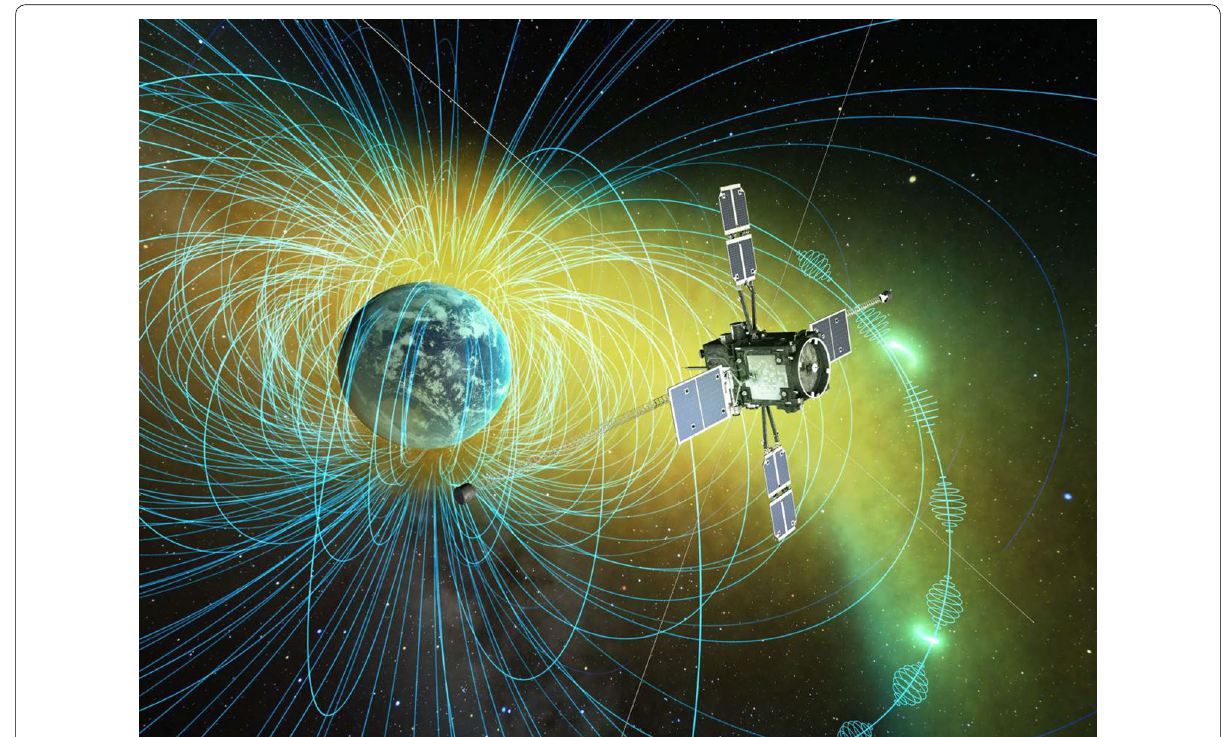
Fig. 1 Image showing the ERG mission, involving in situ measurements of the interactions between plasma waves and electrically charged particles to reveal how these high‑energy electrons are accelerated or created in the Van Allen belts and how space storms